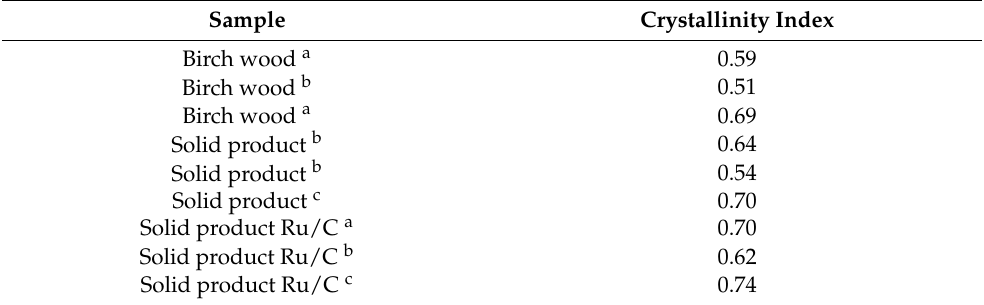
Table 7. Crystallinity indices of the samples of birch wood and solid product of its hydrogenation initial ( a ), alkali-pretreated ( b ) and acid-pretreated ( c ) wood. Sample Crystallinity Index Birch wood a 0.59 Birch wood